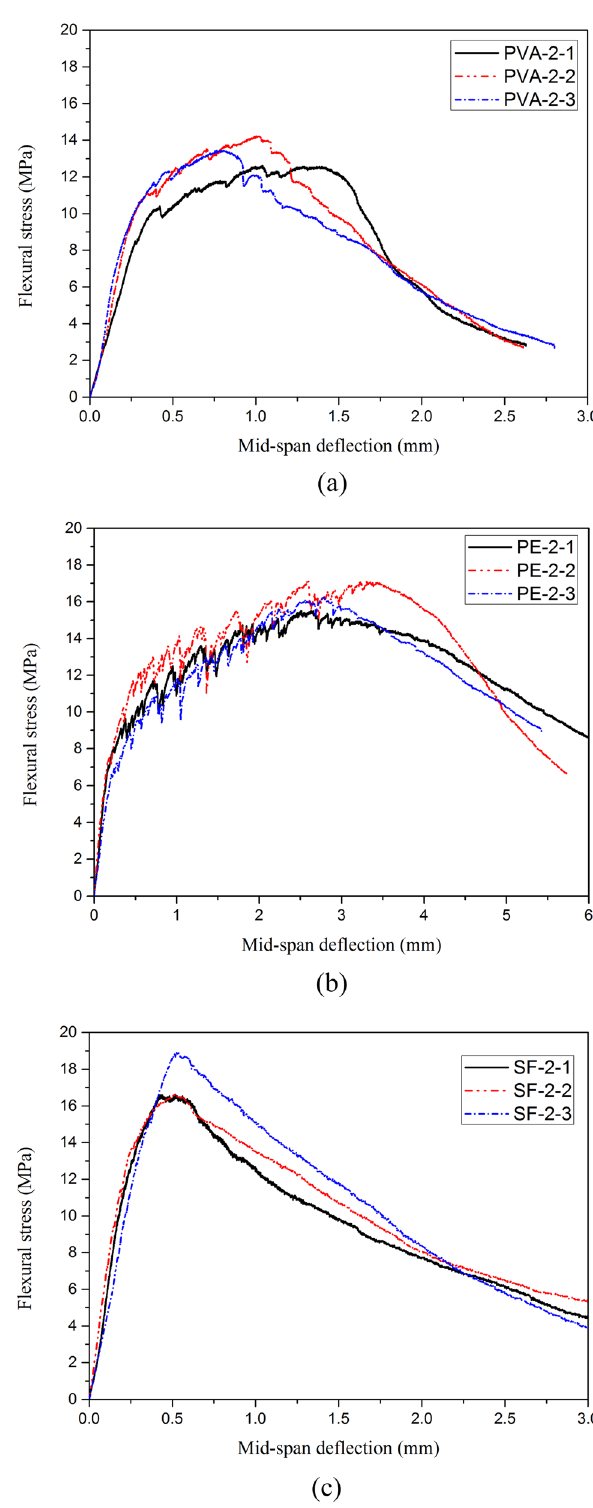
Figure 8: Compressive and fl exural strengths of lightweight cement - based composites.